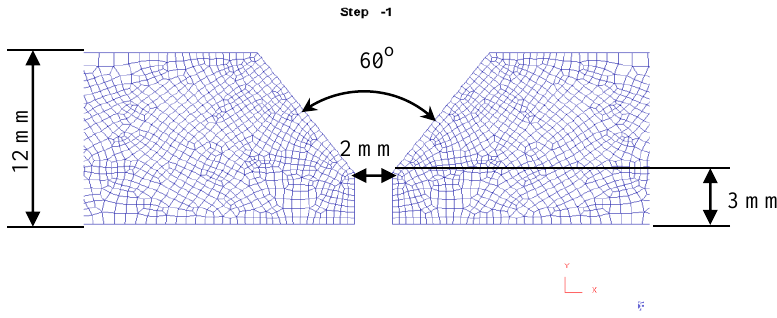
Figure 1. Dimensions of the V-shape welding groove according to ISO 9692 [7].